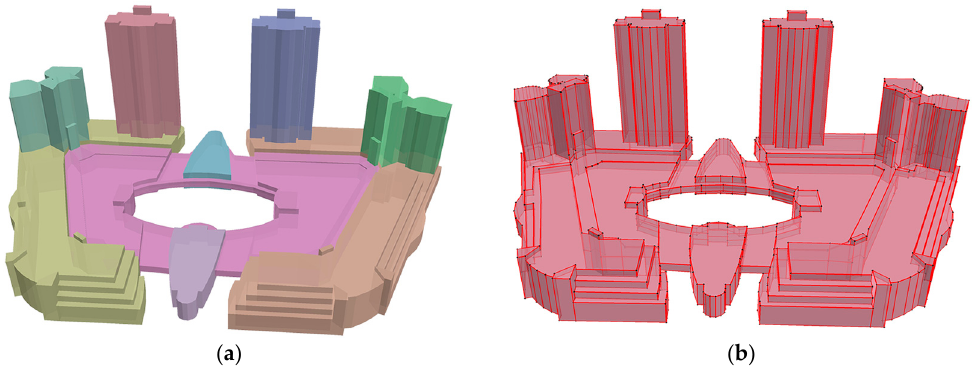
Figure 22. 3D geometric models ( a ) and topologies ( b ) of all the property objects on Pozi Street.